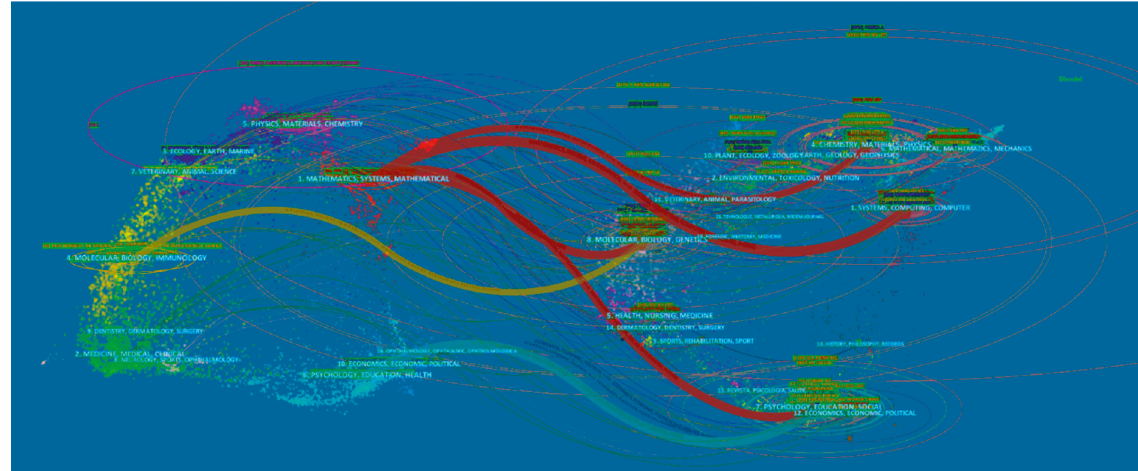
Figure 4: Double-figure overlay for the dynamic complex network research.